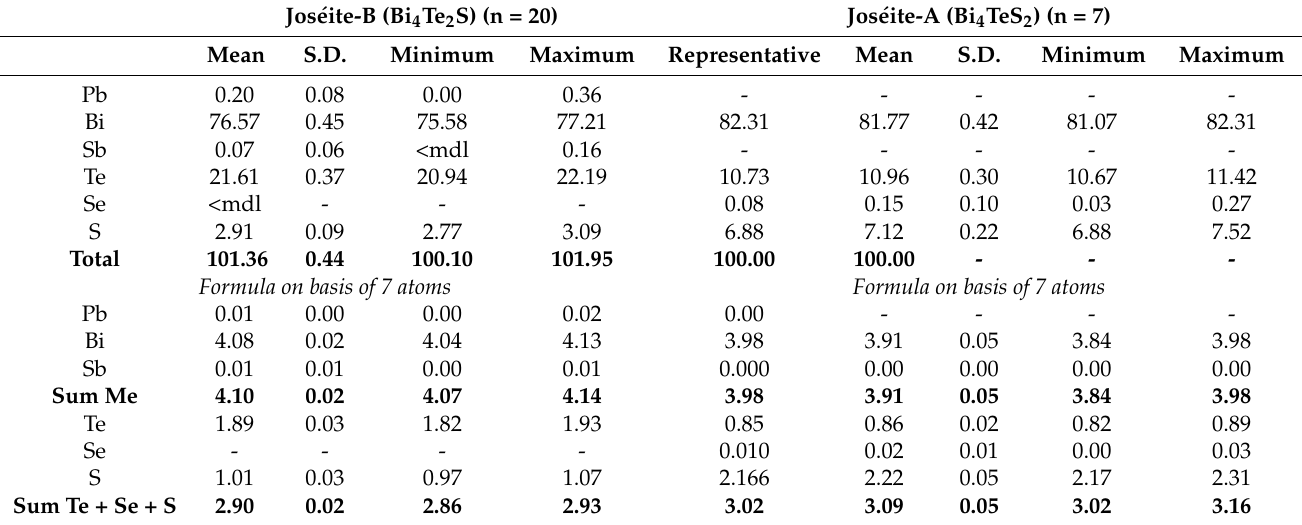
Table 4. Electron probe microanalysis data for jos é ite-B and STEM EDS data for jos é ite-A